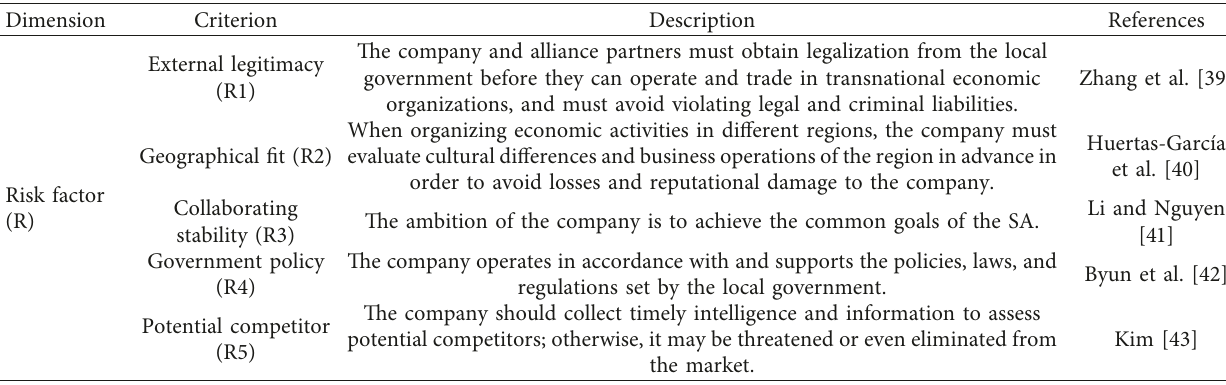
Table 6: The risk factor dimension and its